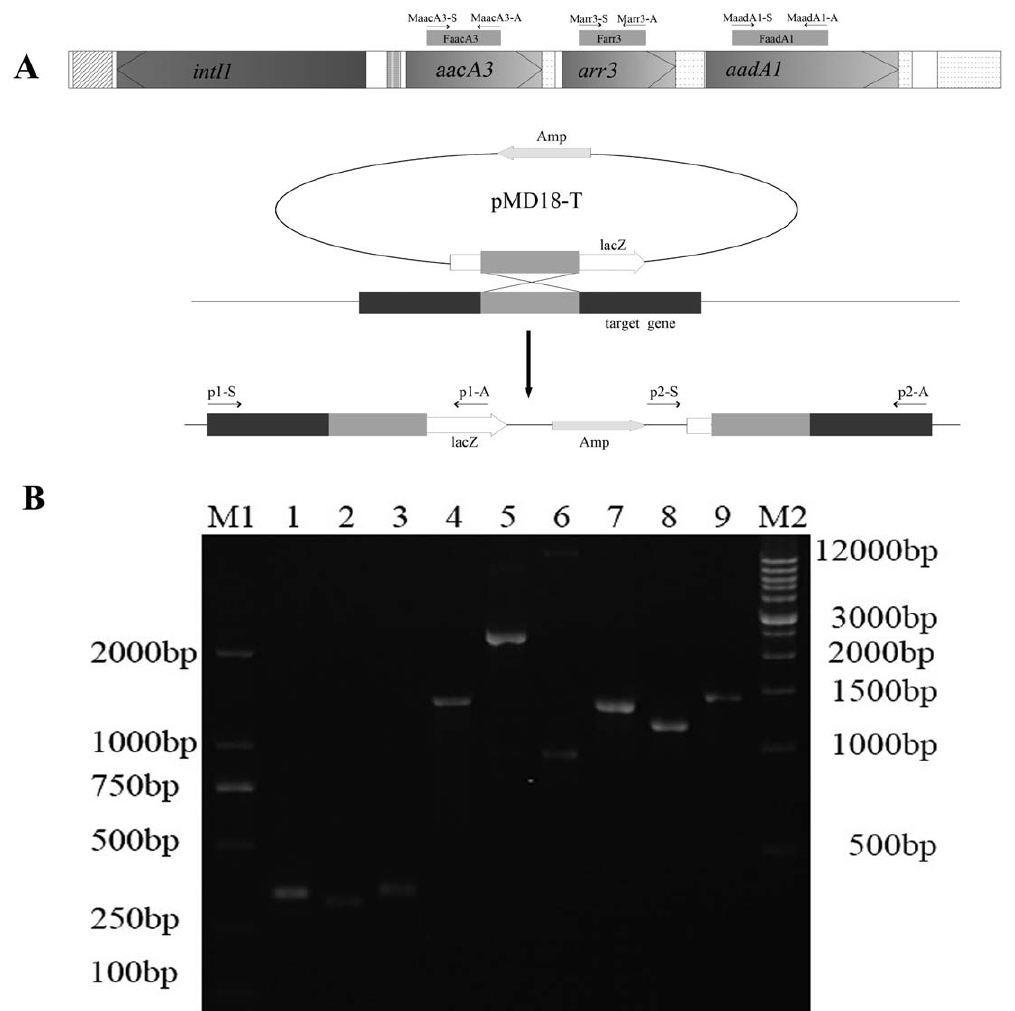
Figure 2. Construction and analysis of resistance gene mutants. A. Schematic representation of homologous single recombination between a target resistance gene fragment cloned in pMD18-T and the target resistance gene in YNA11-2. Location of primers used for PCR is shown in the figure. The shaded box areas represent the target resistance gene while the lightly shaded area represents a cloned resistance gene fragment where homologous recombination occurred between pMD18-T and the genome of YNA11-2. When the mutant MaacA3 was analyzed, the primer accyan1- S, accyan1-A, accyan2-S and accyan2-A were used as the p1-S, p1-A, p2-S and p2-A, respectively. When the mutant Marr3 was analyzed, the primer arryan2-S, arryan2-A, arryan4-S and arryan4-A were used as the p1-S, p1-A, p2-S and p2-A, respectively. When the mutant MaadA1 was analyzed, the primer aadayan4-S, aadayan4-A, aadayan5-S and aadayan5-A were used as the p1-S, p1-A, p2-S and p2-A, respectively. B. Electrophoresis of three resistance genes fragments and PCR identification of three mutants. M1, DNA markers; Lane 1–3, PCR products of three resistance genes fragments FaacA3, Farr3 and FaadA1; Lane 4–9, PCR products of MaacA3 with primer pairs p1 and p2, PCR products of Marr3 with primer pairs p1 and p2, PCR products of MaadA1 with primer pairs p1 and p2; M2, DNA